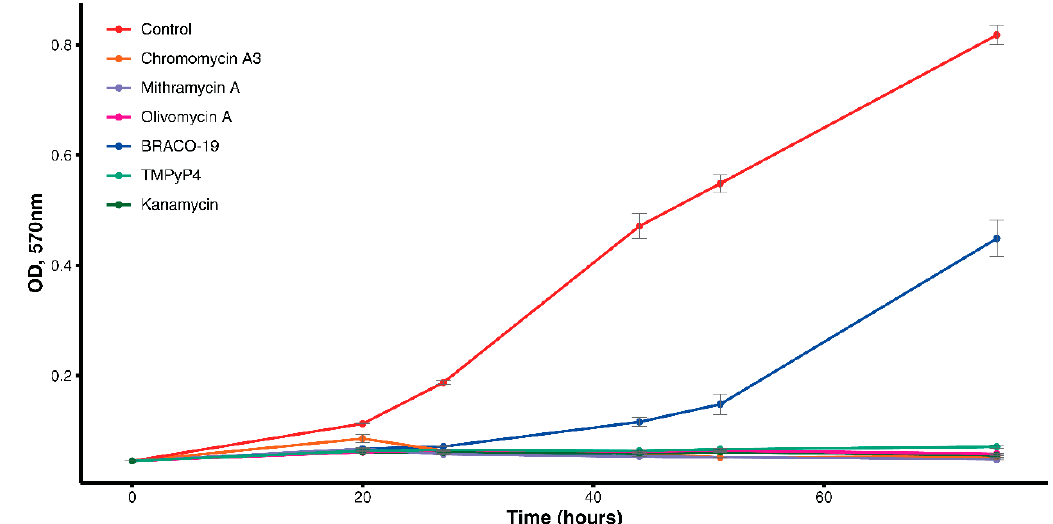
Figure 1. Growth curve of M. smegmatis with drugs and control culture.